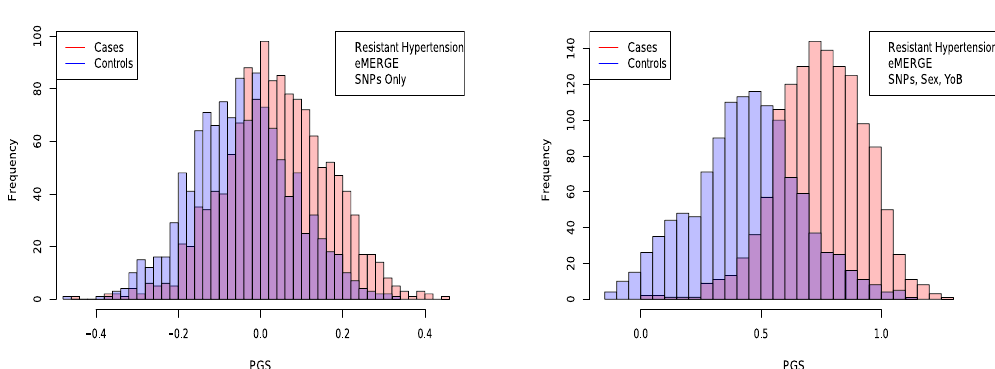
Figure 5. Distribution of PGS, cases and controls for Hypertension in the eMERGE dataset using SNPs alone and including sex and age as regressors.